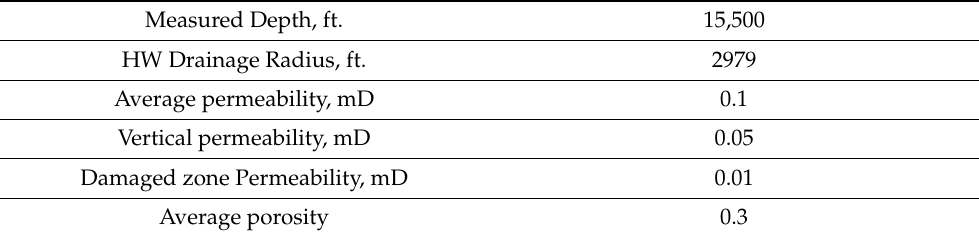
Table 1. Reservoir properties for the case study. Measured Depth, ft.